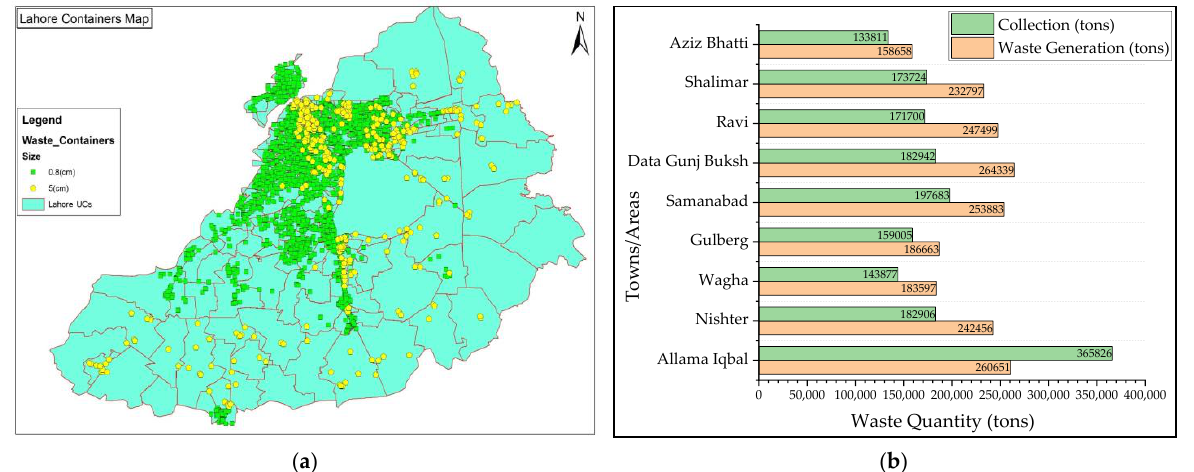
Figure 12. Waste storage and collection: ( a ) location of waste storage containers placed in the city for CBC mode; ( b ) Town-wise waste generation and collection.